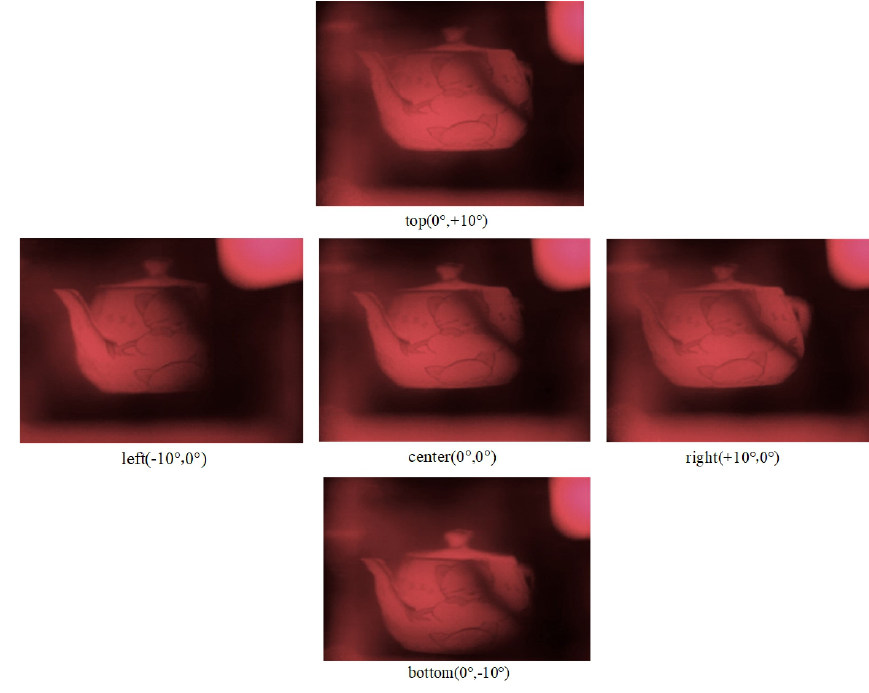
Figure 11. Optical reconstruction images in different viewing position obtained by